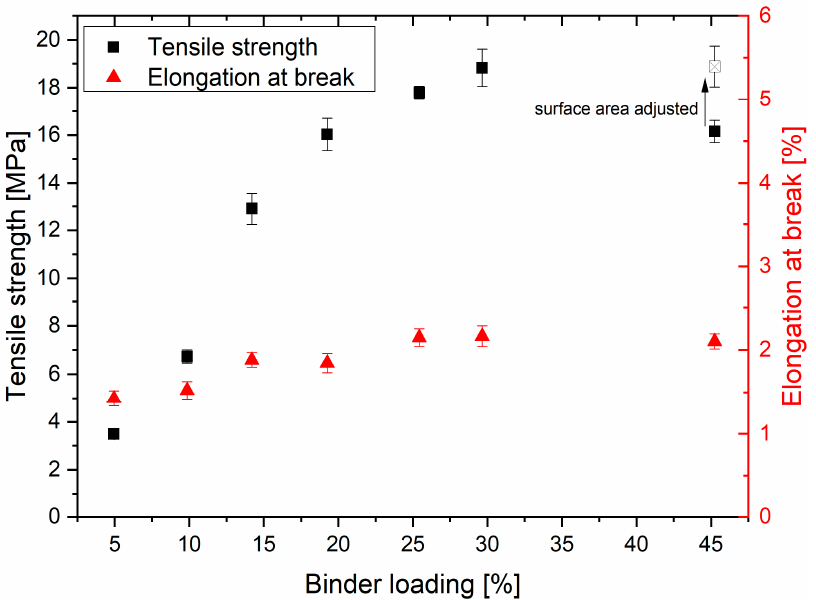
Figure 5. Tensile strength of samples at different binder loadings (BL). Due to the heavy trapezoid shape at 45% BL, the tensile strength was adjusted by determining the actual surface area via optical microscope.